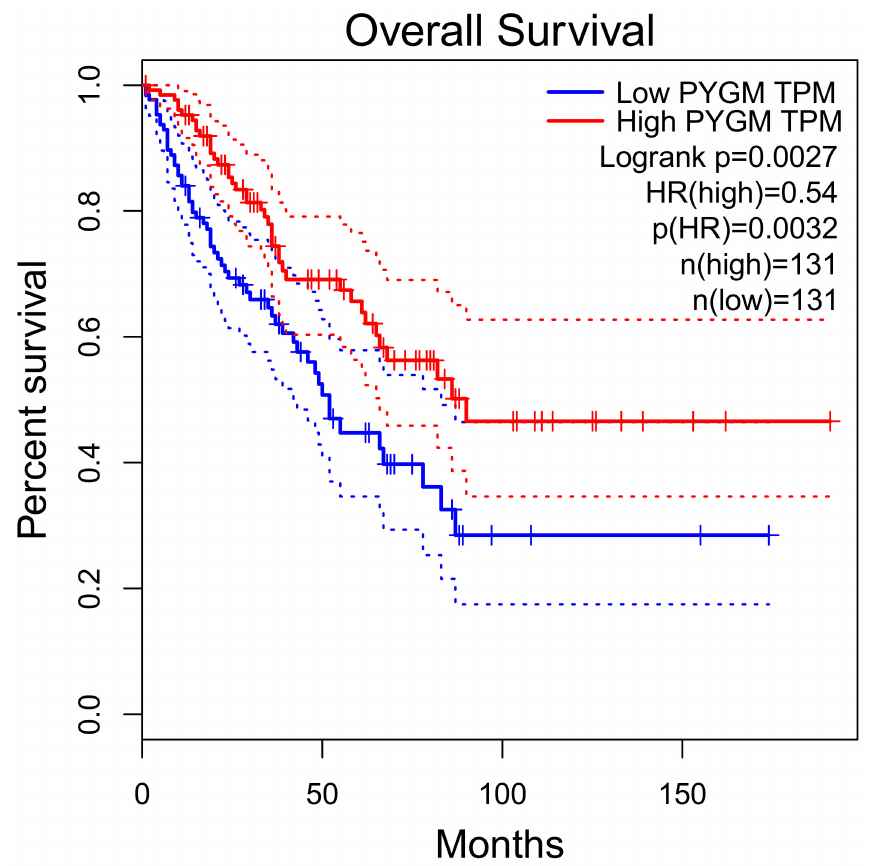
Figure 3. Overall survival rate of patients with sarcoma, depending on the PYGM gene expression rate. Low (median) PYGM expression correlated with poorer survival. Normalized RNA-sequencing data as transcripts per million (TPM). HR—hazard ratio calculated using Cox PH Model. The solid line represents the survival curve and the dotted line represents the 95% confidence interval. According to the Gene Expression Profiling Interactive Analysis, GEPIA, available online www.gepia.cancer (accessed on 4 February 2021)